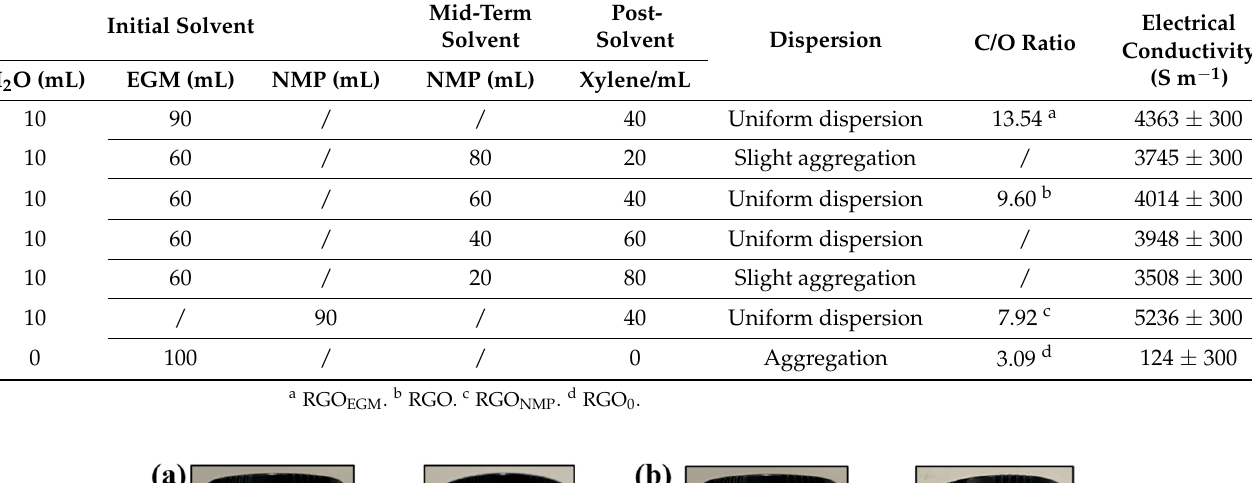
Figure 2. ( a , b ) SEM image of GO, ( c , d ) TEM image of GO, ( e , f ) SEM image of RGO, and ( g , h ) TEM image of RGO.